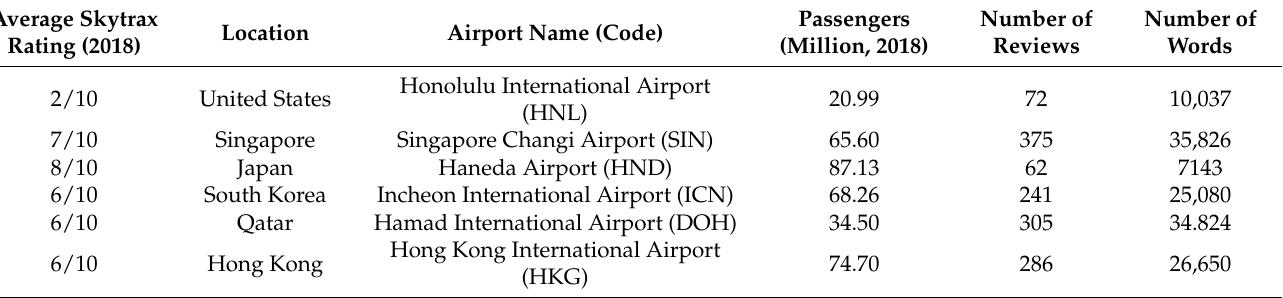
Table 1. Information of the Honolulu International Airport and the World’s Leading Airports.